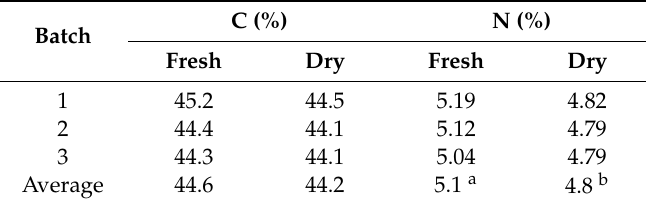
Table 4. C and N contents of mushrooms before and after drying.